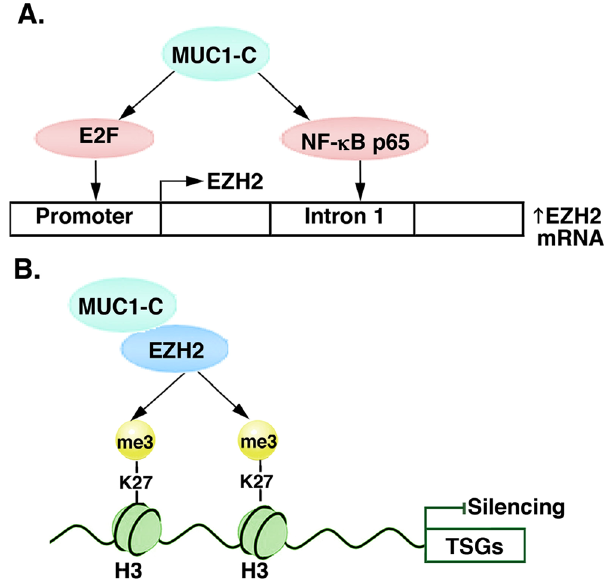
Figure 8. Schemas depicting the proposed MUC1-C-induced regulation of EZH2 expression and function in epigenetic repression. ( A ) MUC1-C drives EZH2 expression by inducing (i) the pRB → E2F pathway and in turn E2F-mediated activation of the EZH2 promoter, and (ii) NF- κ B p65 occupancy of the EZH2 intron 1 and enhancing EZH2 transcription. ( B ) MUC1-C binds directly to EZH2, increases EZH2 occupancy on TSG promoters and enhances EZH2-mediated H3K27 trimethylation with repression of gene